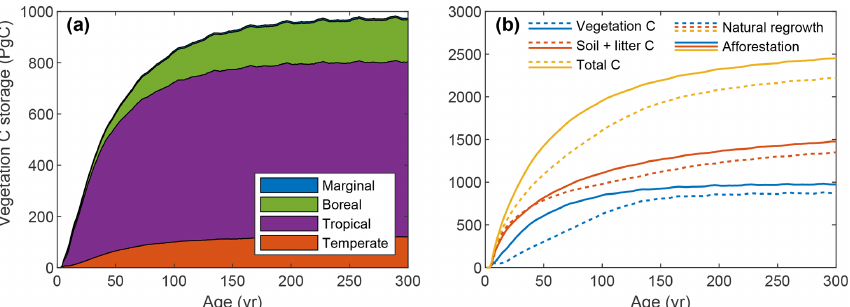
Figure 7. Global total ecosystem C over time for simulations with global forest plantations or global natural vegetation. (a) Vegetation C storage per biome for the global forest plantation simulation only; (b) C storage per compartment for both simulations.